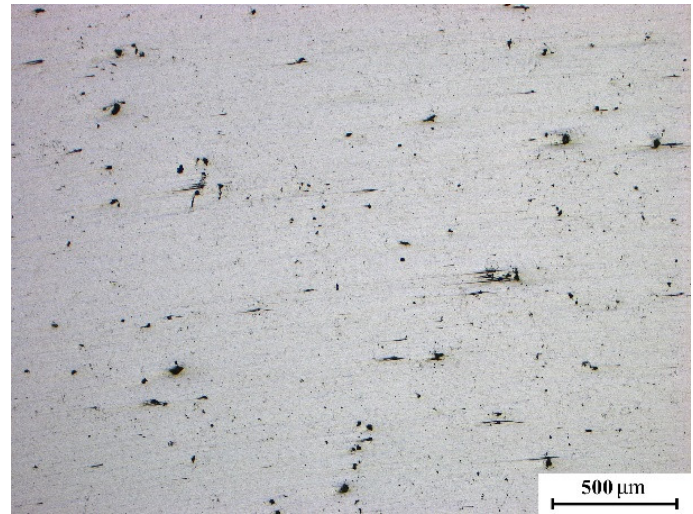
Figure 13. Metallographic photo of the spray-formed alloy ingot.